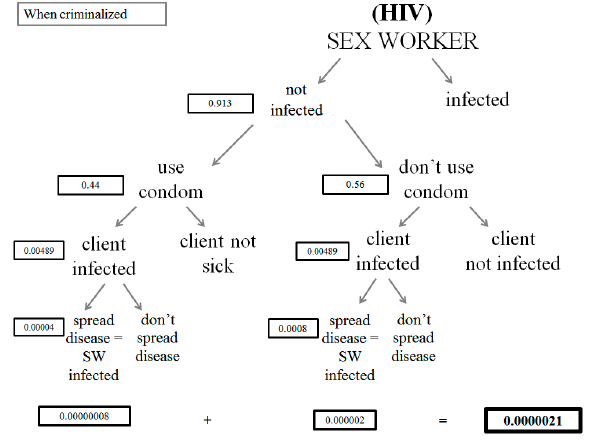
Figure A5. Probability tree of client’s risk of infection.